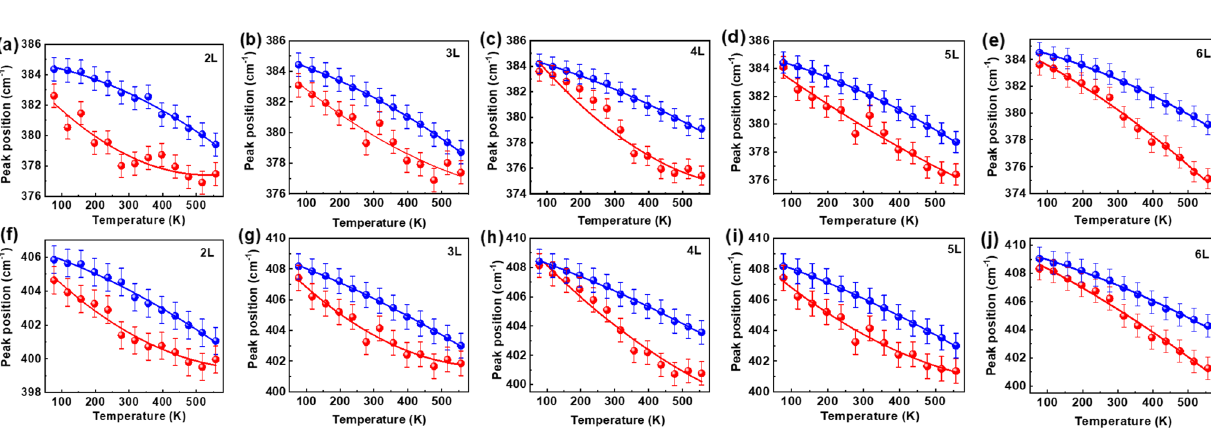
Figure 4. Temperature dependence of peak positions of the ( a – e ) E 2g and ( f – j ) A 1g modes for the suspended and supported MoS 2 with different numbers of layers. The blue spheres and red spheres represent the experimental results of supported and suspended MoS 2 , respectively. The blue lines and red lines are the fitting results obtained using a second-order polynomial function of